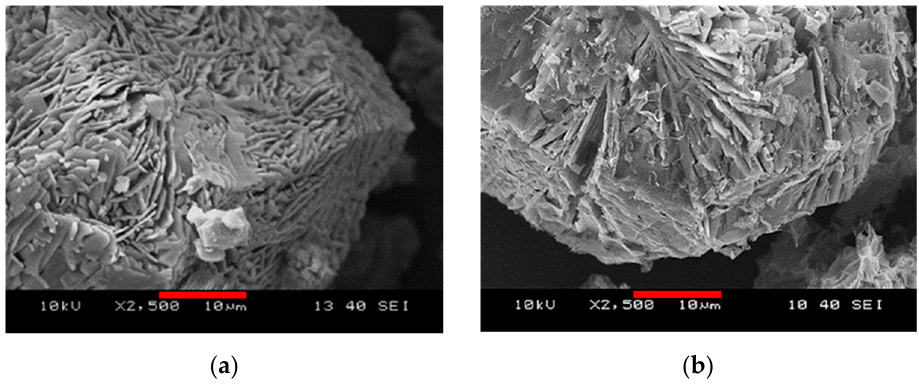
Figure 10. SEM images of ( a ) HKUST-1_110°C_85%RH and ( b ) HKUST-1@GO-2_110°C_85%RH. The scale bar is 10 µm.